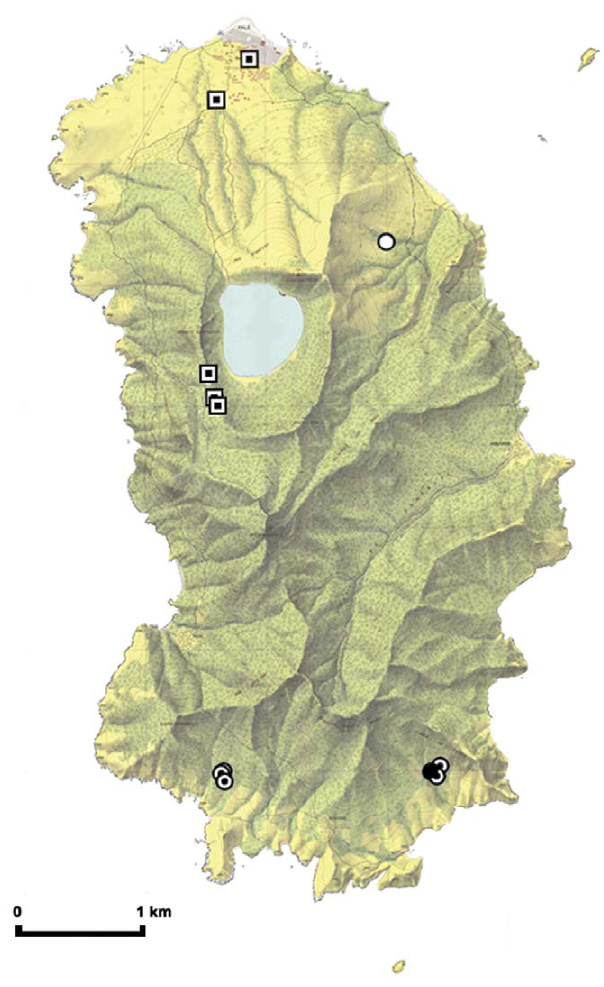
Figure 2. Map of Annobo´n indicating Eidolonhelvum colonies and sampling sites. Key: Circles indicate colony locations (open circle: colonies were reported or used to exist in the past, but no bats were found; partially filled circle: colony observed, but not sampled; filled circle: colony observed and sampled). Squares indicate sites where Eidolon bats have been observed feeding at different times of the year.